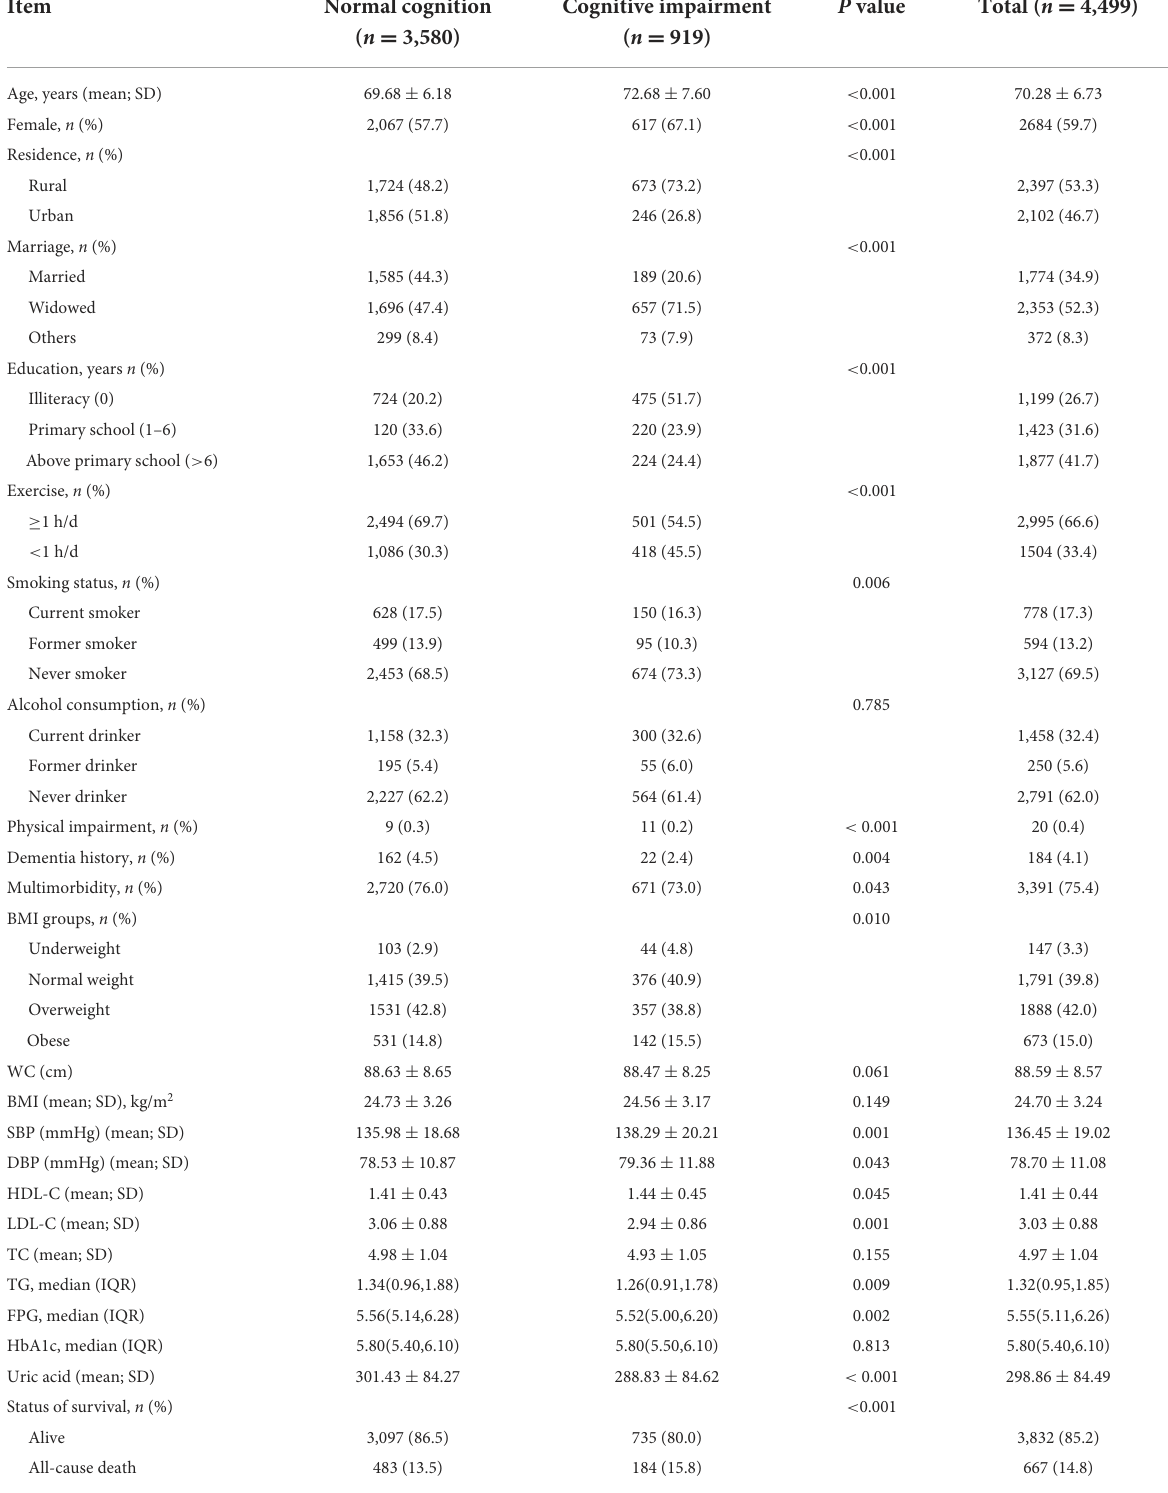
TABLE 1 Characteristics of participants according to different cognitive function